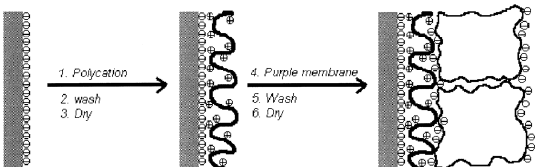
Figure 21. Schematic of poly (dimethyldiallylammonium chloride)/purple membrane (PDAC/PM) alternate assembly using a negatively charged solid support. Reprinted with permission from reference [151]. Copyright 1998 American Chemical Society.